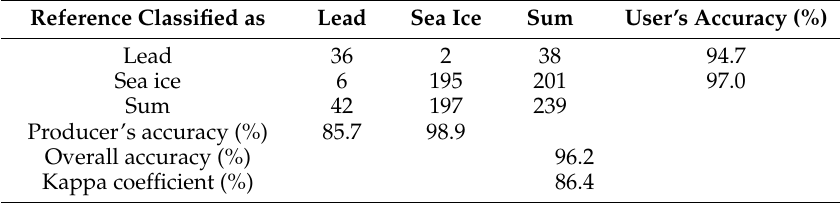
Table 8. The error matrix based on the random forest-based lead detection results for IC.